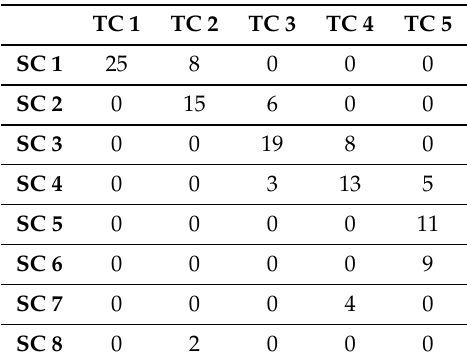
Table 1. Quantitative performance assessment for the proposed hierarchical agglomeration algorithm: confusion matrix. Stepwise criterion (SC) 1–8 are the obtained classes, while TC 1–5 are the ground truth-based classes.